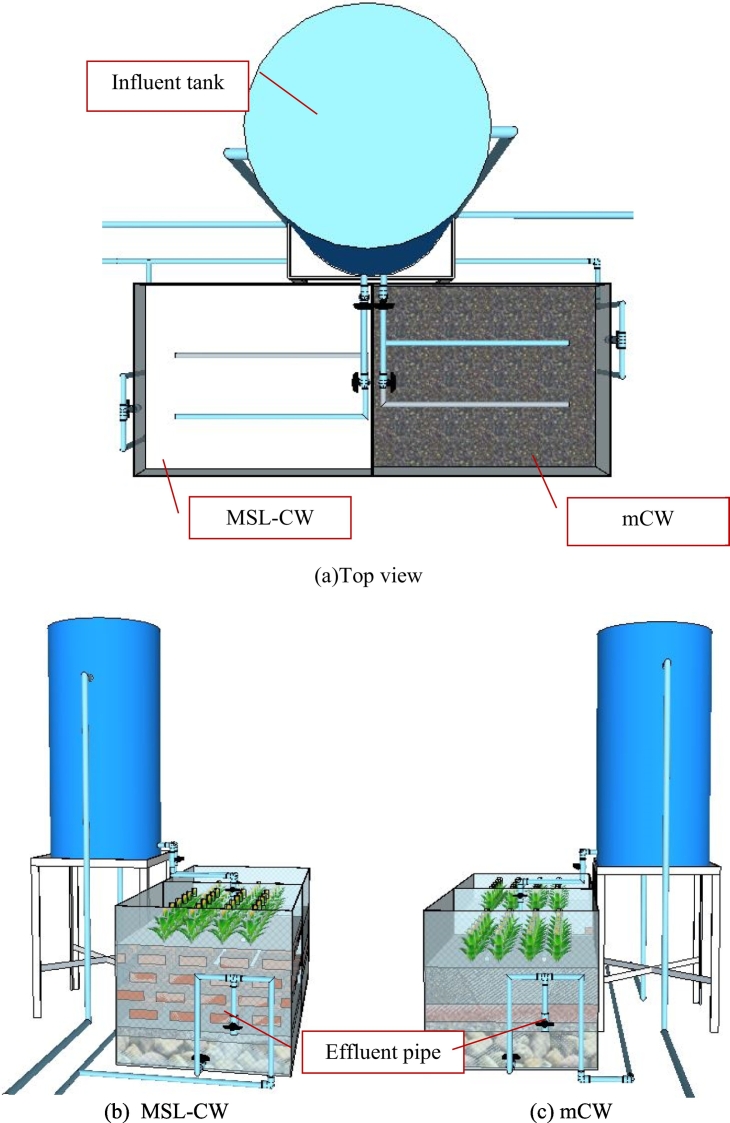
Experimental set up.